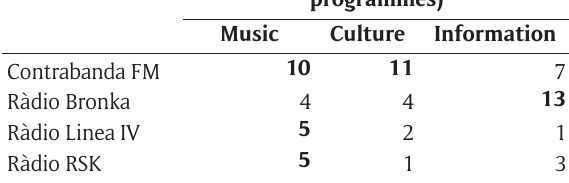
Table 1: Contrabanda FM, Ràdio Bronka, Ràdio Linea IV and Ràdio RSK programming description